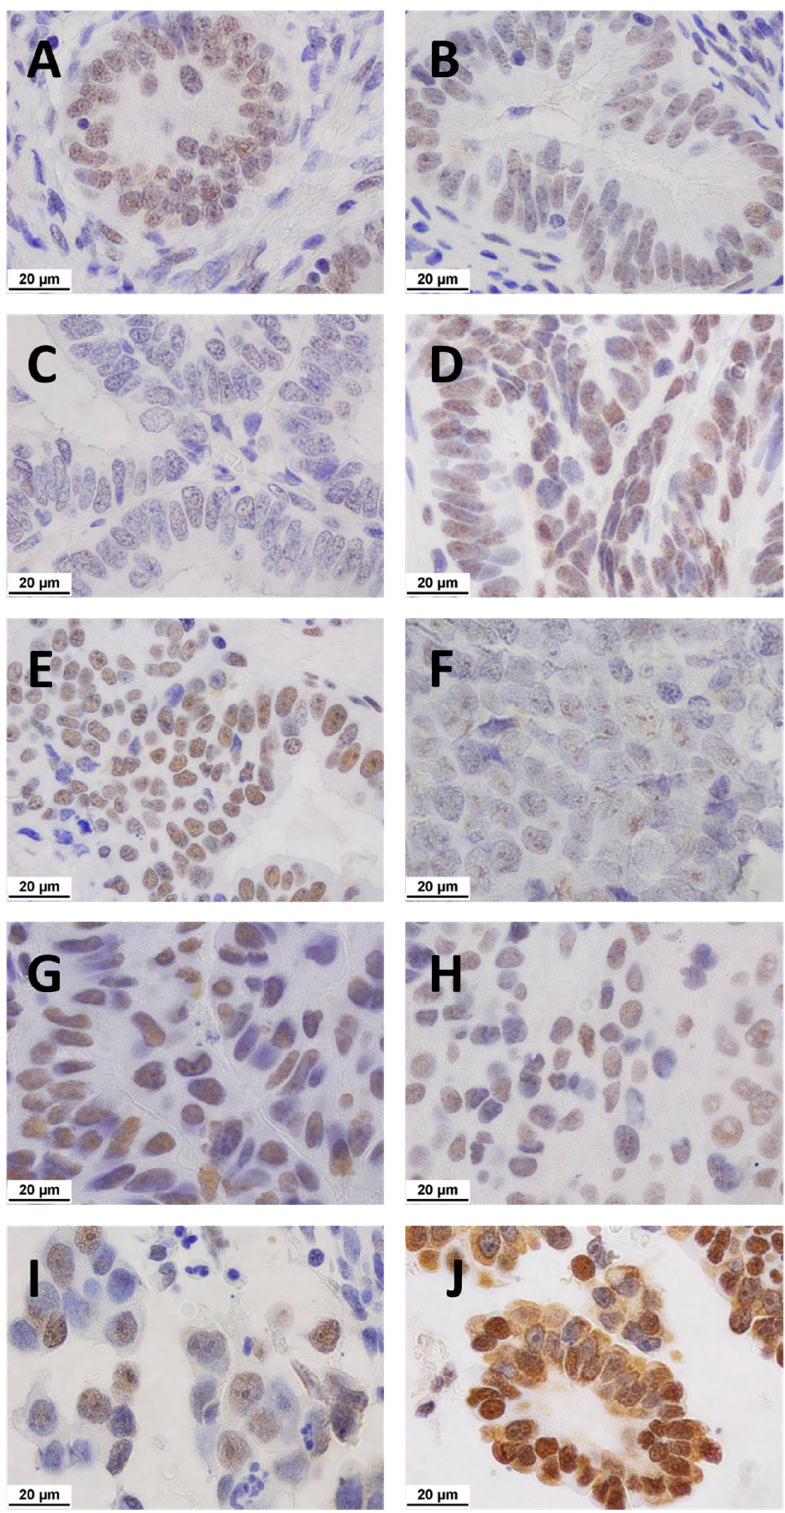
Figure 3. Representative microphotographs of immunolocalised nucleolar NCL expression in different tissues. Positive staining indicated by brown nucleoli. All images seen at ×1000 magnification. Scale bar = 20 μ m, applicable to all panels. ( A ) Pre-menopausal ( B ) post-menopausal ( C ) hyperplasia ( D ) G1 endometrioid EC ( E ) G2 endometrioid EC ( F ) G3 endometrioid EC ( G ) serous EC ( H ) carcinosarcoma EC ( I ) clear cell EC ( J ) mixed. The median scores for each group were 6.8, 5.1, 2.8, 6.5, 5.8, 4.6, 6.6, 5.1, 6.4, and 8.3, respectively.